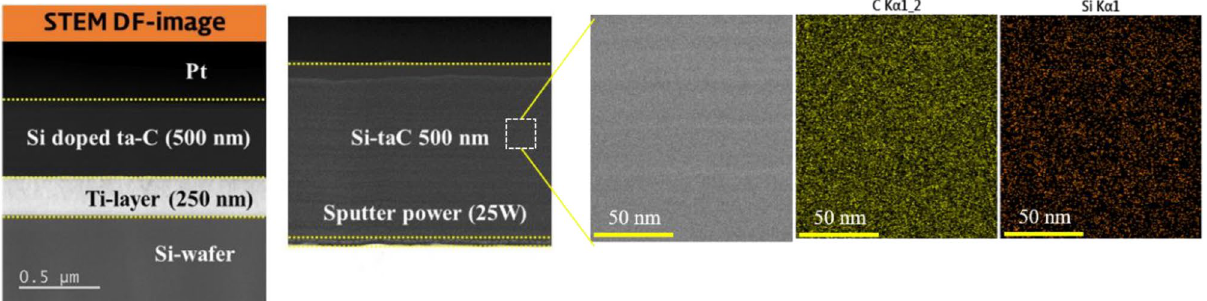
Figure 2. Scanning transmission electron microscopy (STEM) Dark Field (DF) images and energy dispersive X-ray spectroscopy (EDS) data of Si/SiC/ta-C composite (Si–ta-C) coating with a representative sputtering power of 25 W (indicated by white-dashed square). 1.25 at.% Si/SiC/ta-C composite deposited on Si-wafer and was prepared by cross-sectional cutting through focused ion